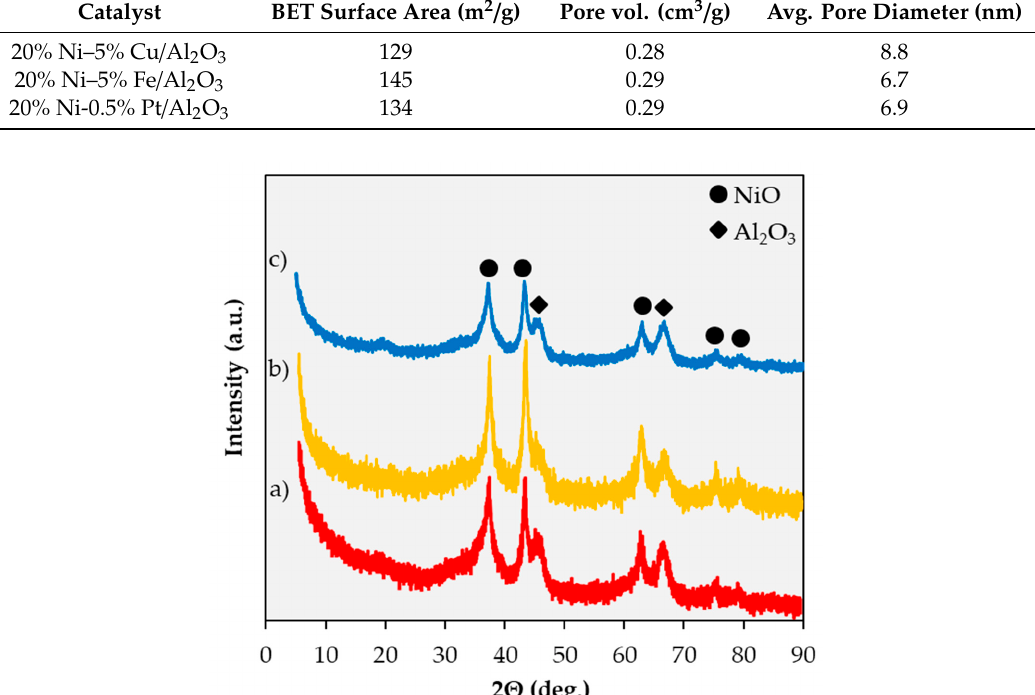
Figure 3. X-ray di ff raction patterns for 20%Ni–5%Fe / Al 2 O 3 ( a ), 20%Ni–5%Cu / Al 2 O 3 ( b ), Figure 3. X-ray diffraction patterns for 20%Ni–5%Fe/Al 2 O 3 ( a ), 20%Ni–5%Cu/Al 2 O 3 ( b ), 20%Ni– 20%Ni–0.5%Pt / Al 2 O 3 ( c 0.5%Pt/Al 2 O 3 ( c ).